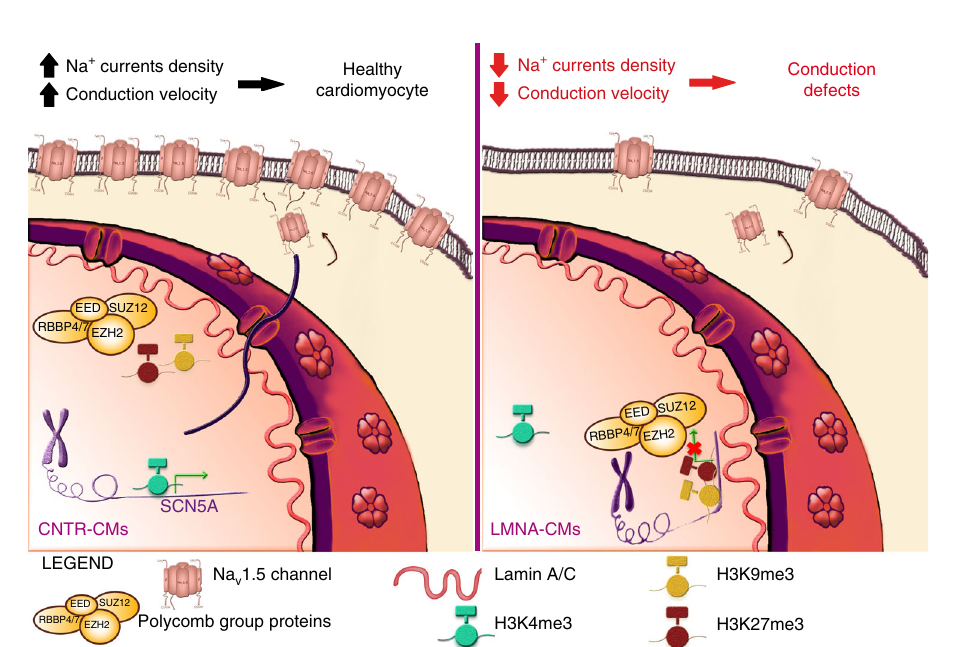
Fig. 10 Proposed pathogenic mechanism of action of K219T-Lamin A/C in CMs. Left: healthy CMs. The SCN5A genomic region is localized in the nuclear interior and actively transcribed; the Na v 1.5 sodium channel density at the plasma membrane is suf fi cient to assure proper impulse propagation. Right: Laminopathic CMs. Mutant Lamin A/C and PRC2 bind each other with high af fi nity and are enriched at the SCN5A promoter region, where the H3K27me3 (catalyzed by PRC2) and H3K9me3 repressive histone marks are also present. In this repressive environment, this genomic region is preferentially sequestered at the nuclear periphery. As a result, SCN5A gene transcription is repressed, leading to reduced expression of the Na v 1.5 sodium channel at the plasma membrane, which, in turn, has an effect on reducing conduction velocity. This regulatory mechanism may be at the basis of the onset of the conduction defects in patients with